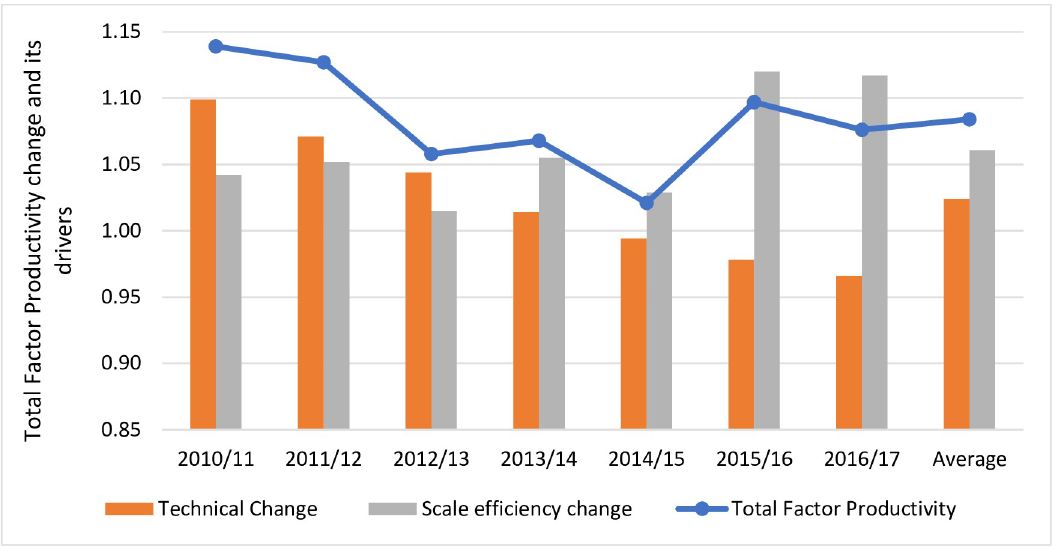
Fig 1. Average total factor productivity change estimation and its drivers for the Chilean water companies.